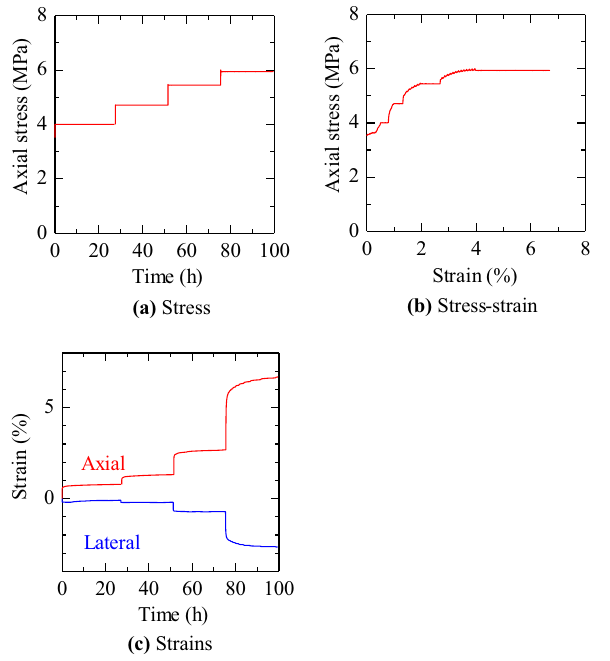
Fig. 16 Example of the results of the triaxial creep